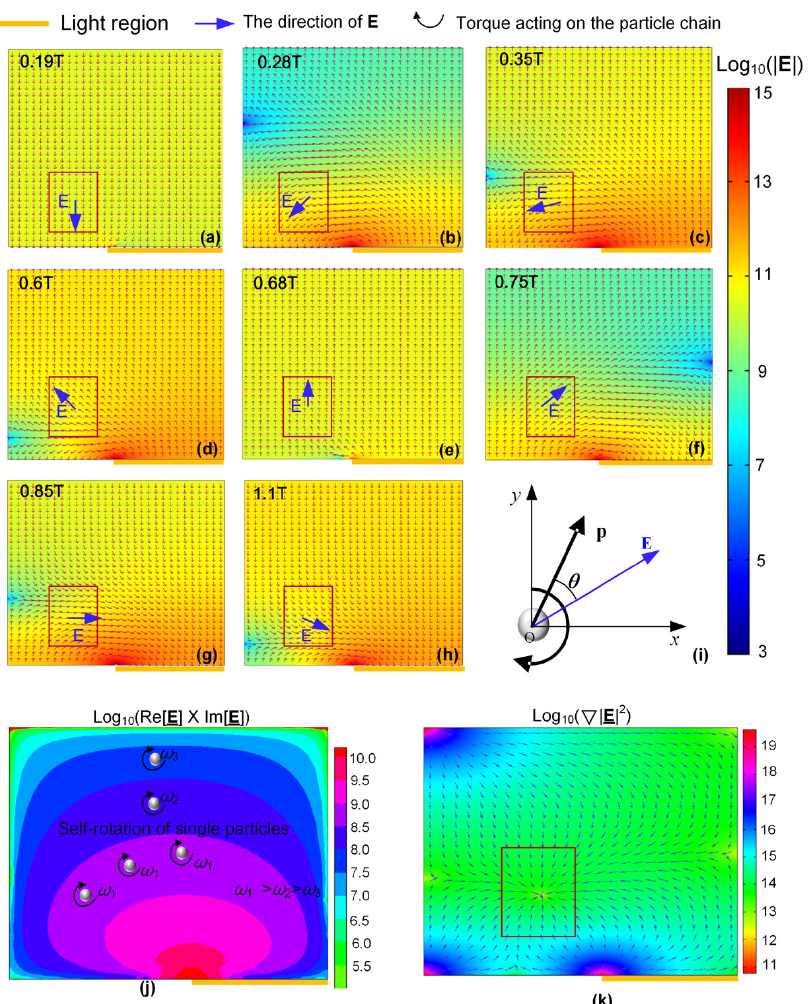
Figure 4. Numerical simulation results for the rotating electric field inside OET chip. ( a – h ) Distributions of the directions (arrows) and magnitudes (surface plot) of electric field at different time instants. ( i ) Schematically illustration of the phase lag between effective dipole moment p of a single particle and rotating e-field strength E . ( j ) Distribution of the characterization factor of rotating field. T denotes the period of applied AC signal. ω 1 , ω 2 , and ω 3 are the rotation rates. The size of simulation domain is set as 60 μm (width) × 100 μm (height) in ( a – h ) and 70 μm (width) × 100 μm (height) in ( j – k ). The width of light region is kept as 30 μm. The amplitude and frequency are set V 0 = 5 V and 700 kHz respectively.